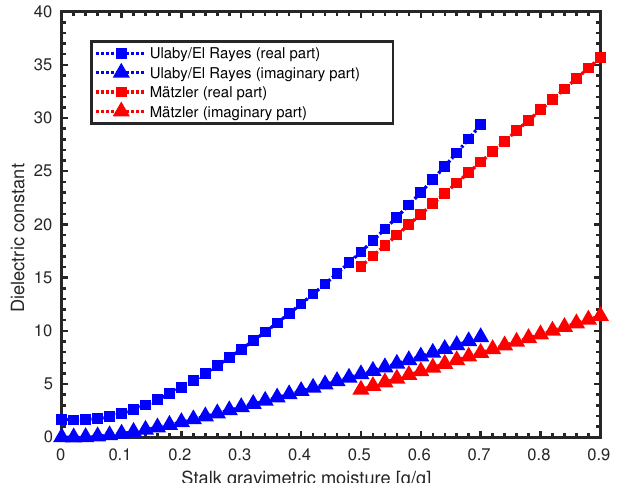
Figure 3. Microwave dielectric model for bulk vegetation from Ulaby and El Rayes [25,32] and from Mätzler